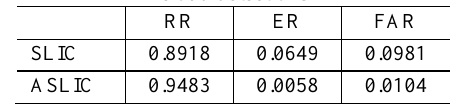
Table 1. Statistics the results of RR 、 ER and FAR for